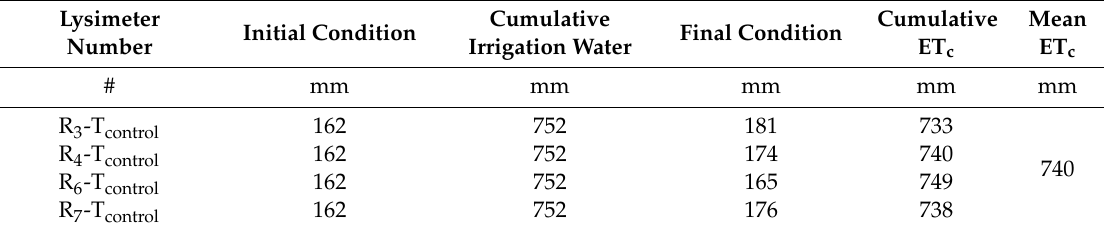
Table 2. Total canola water-use for the control treatments.